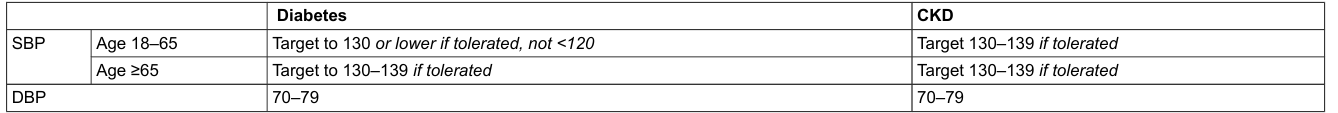
Table 4: Office blood pressure treatment target ranges (modified from Williams et al. J Hypertens. 2018;36:1953-2041 [36]).